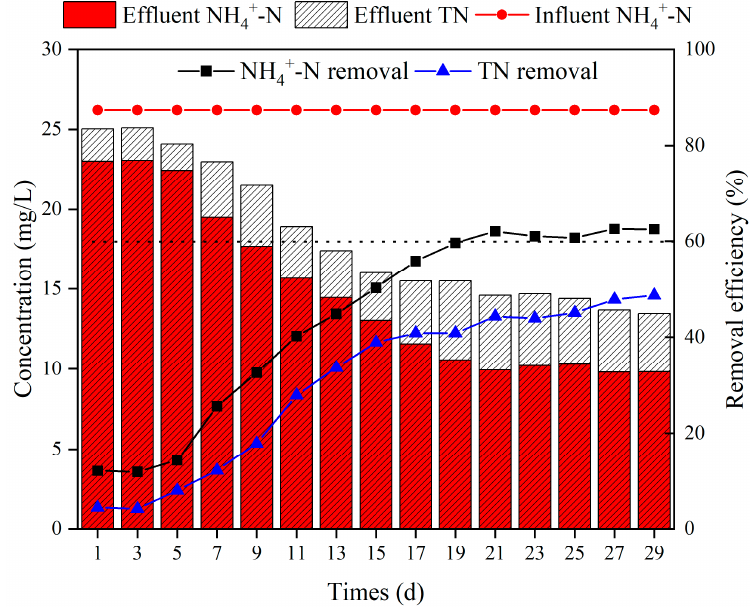
Figure 2. The removal efficiency of ammonium and TN during the start-up period of